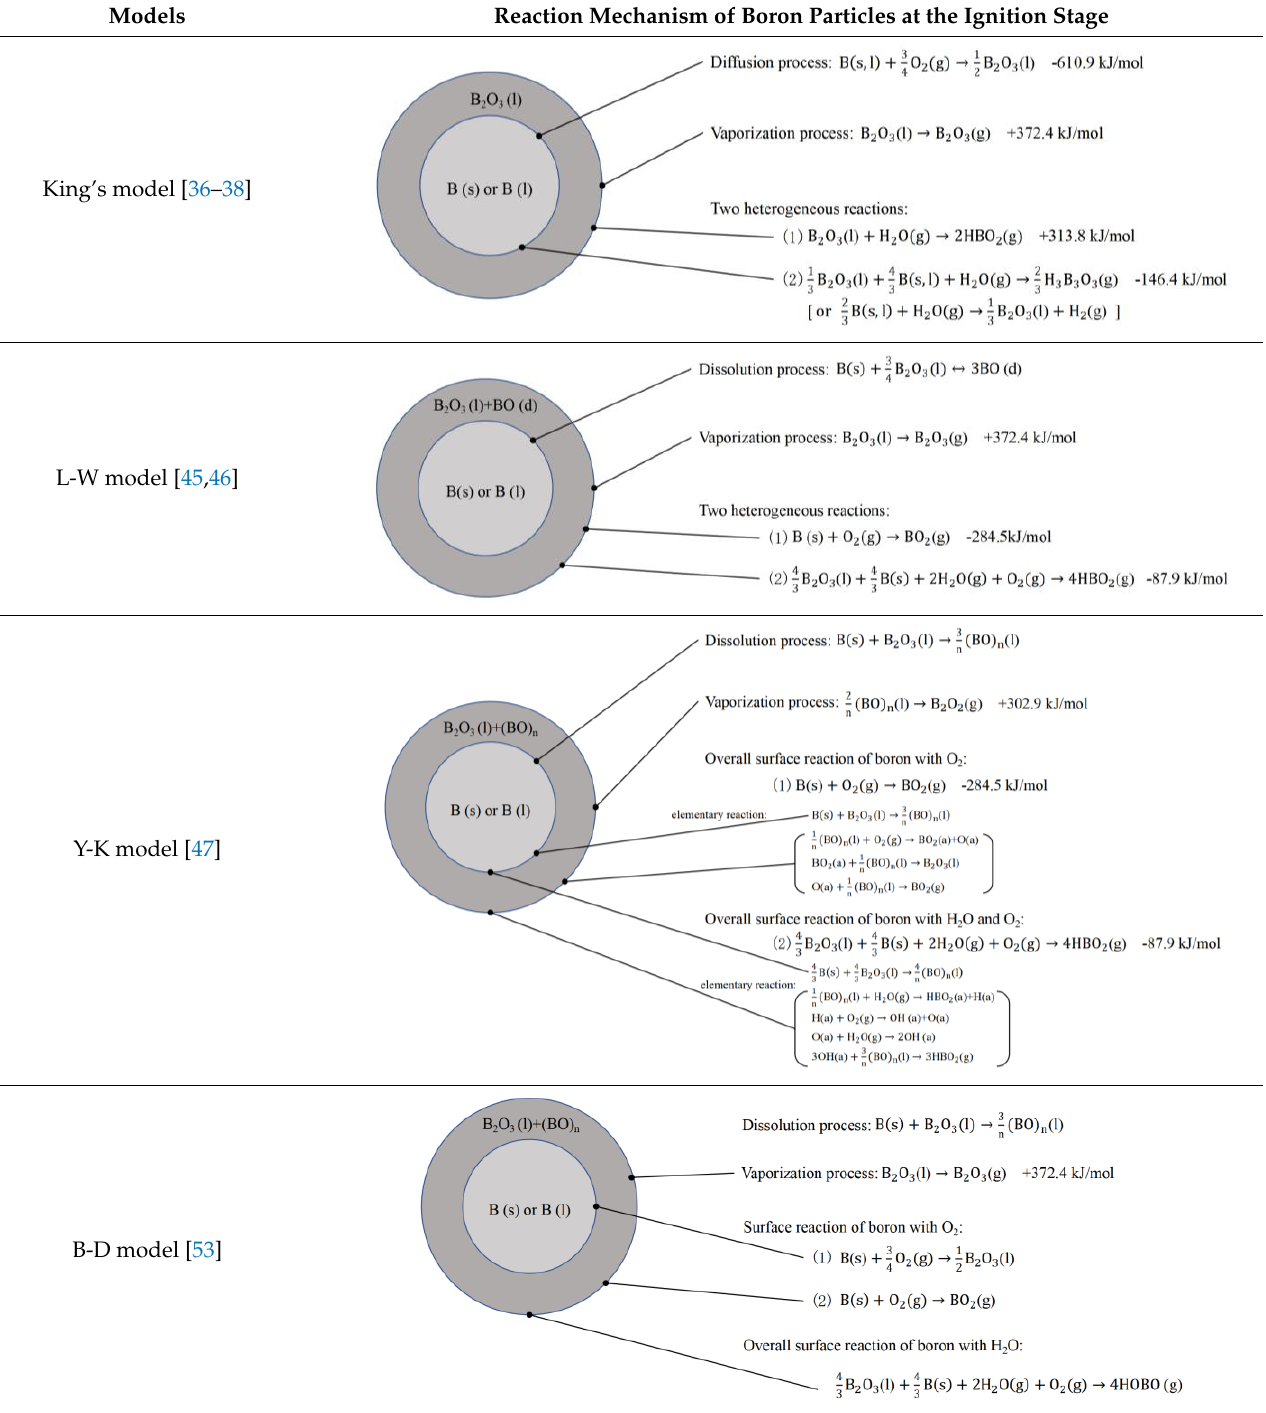
Table 1. Four ignition models of boron particles.